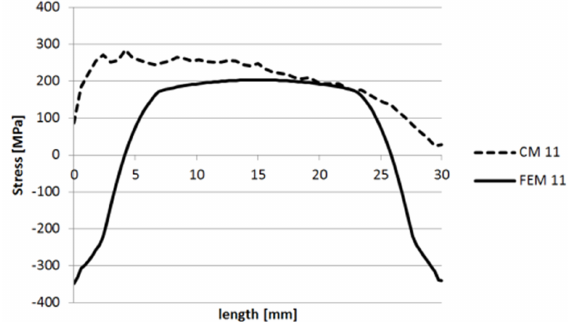
Figure 39. Stress levels in 11 direction along the AB line